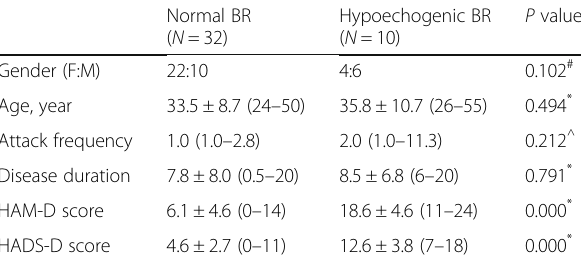
Table 3 Comparison of clinical characteristics between migraineurs with and without hypoechogenicity of BR Normal BR Hypoechogenic BR ( N = 32) ( N =